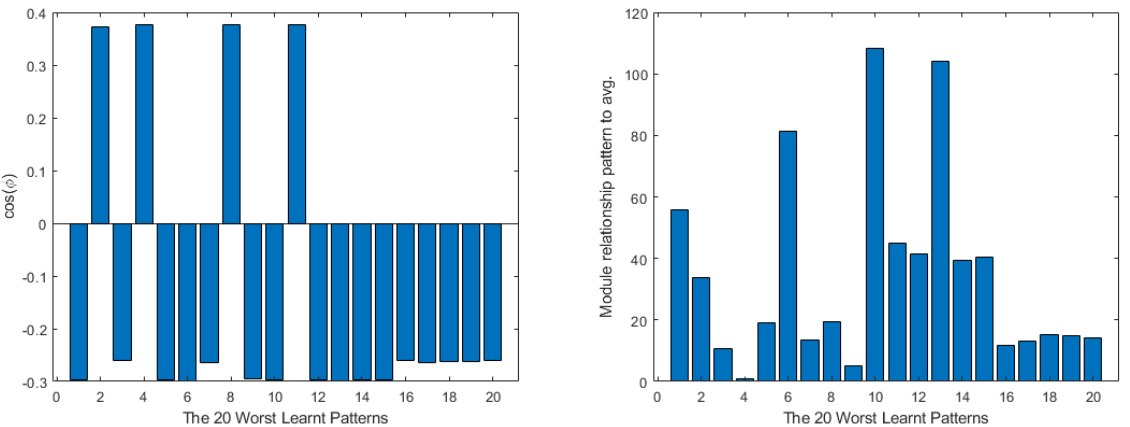
(cid:12) (cid:12) 𝜕𝐿𝑜𝑠𝑠 ∂ Loss (cid:12) (cid:12) | relationship to the average (cid:12) (cid:12) relationship to the average ∂ W n 𝜕𝑊 𝑛